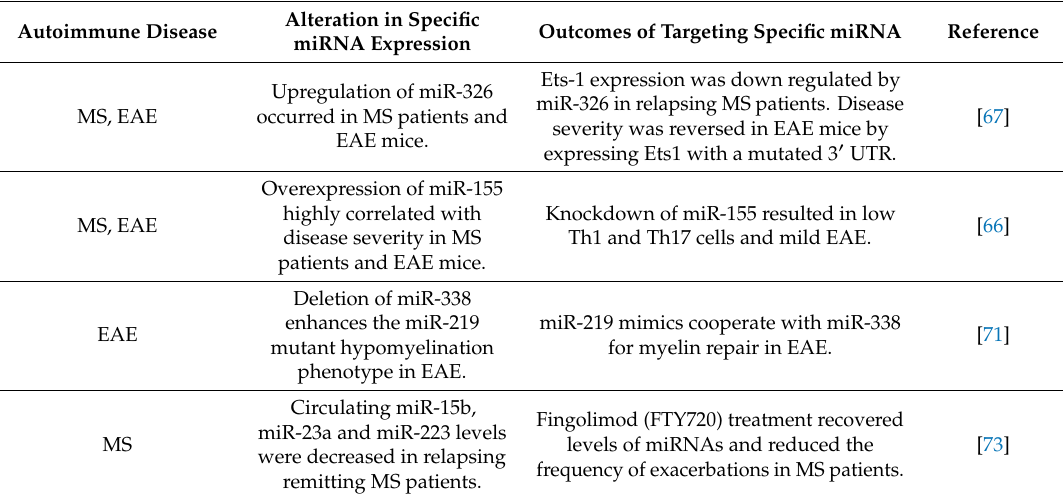
Table 2. Emerging therapeutic strategies for alteration in levels of specific miRNAs in the treatment of MS and